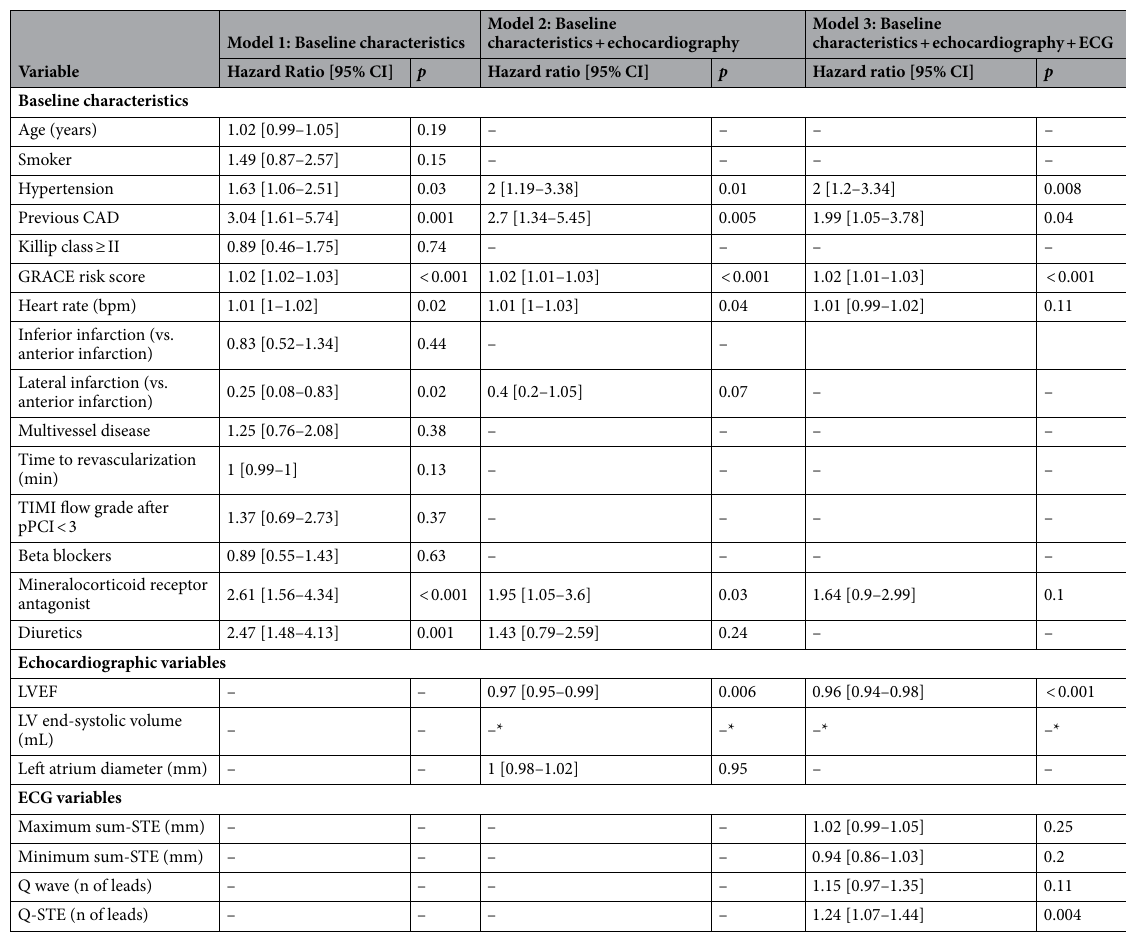
Table 3. Predictors of MACE on multivariable analysis. bpm Beats per minute, CAD Coronary artery disease, CI Confidence interval, GRACE Global Registry of Acute Coronary Events, LV Left ventricular,